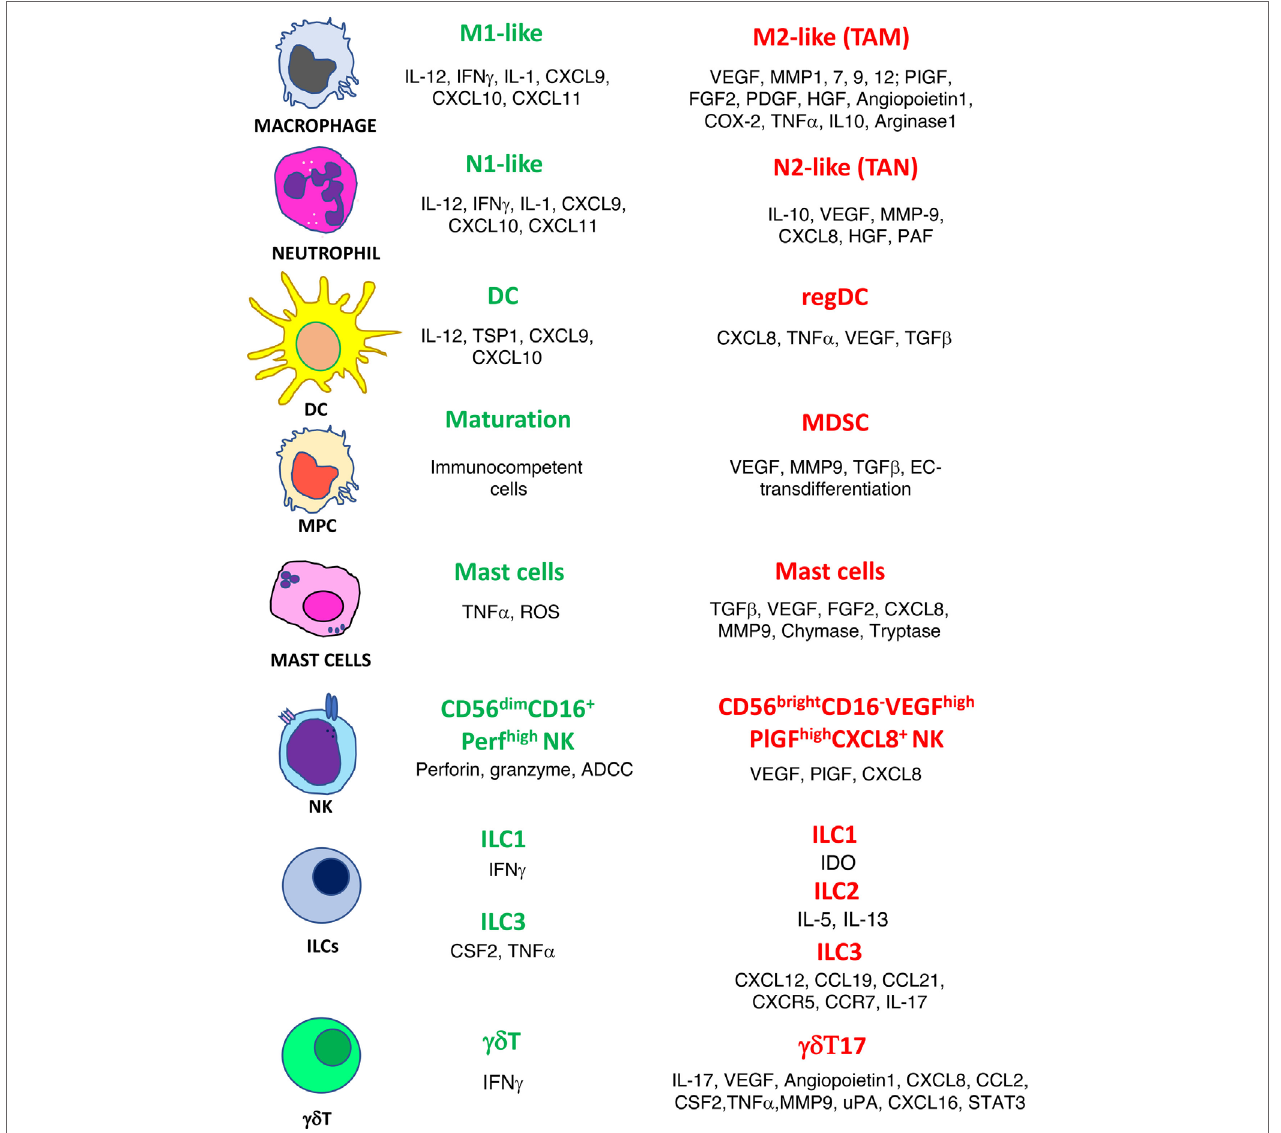
FigURe 1 | Phenotype switch of innate immune cells in cancer. Antitumor/antiangiogenic (green text) and protumor/proangiogenic (red text) features are listed for macrophages, neutrophils, dendritic cells (DC), myeloid precursor cells (MPC), mast cells, natural killer cells (NK), innate lymphoid cells (ILCs), and γδ T cells.